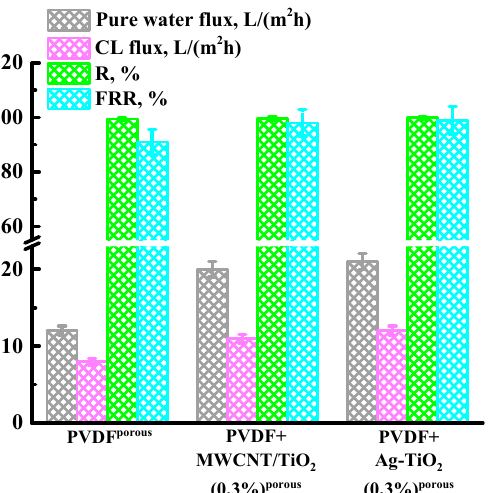
Figure 4. Dependence of pure water flux, CL flux, CL rejection coefficient (R), and flux recovery ratio (FRR) on the TiO 2 concentration in the PVDF matrix during CL ultrafiltration at 1 bar. The ultrafiltration experiment was carried out for 2 h.